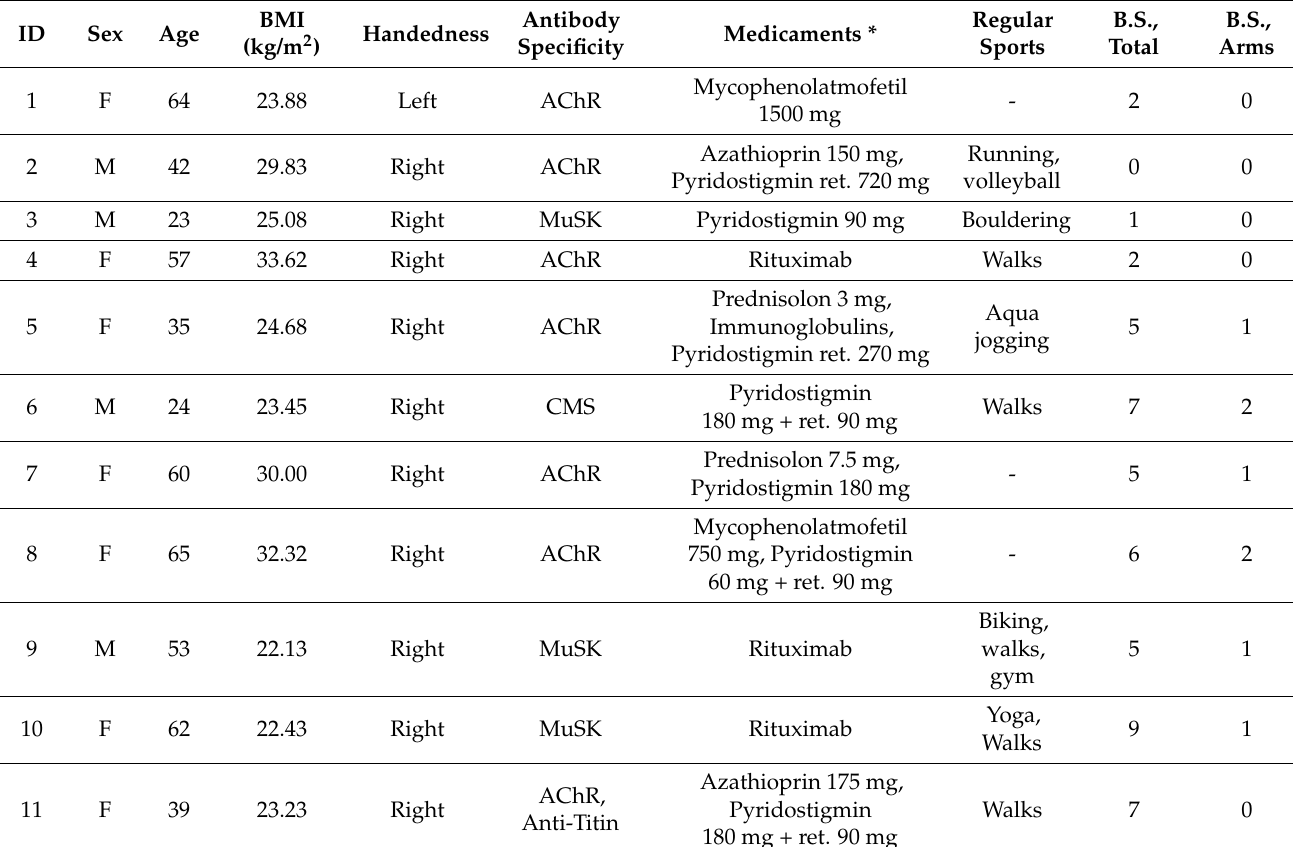
Table 1. Patient